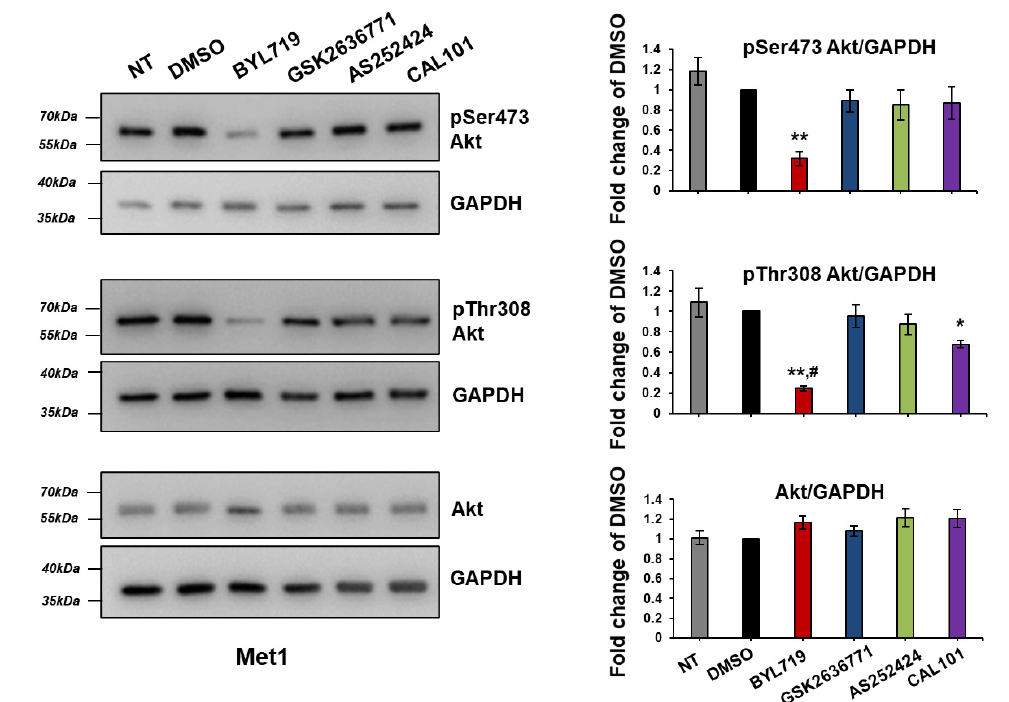
Figure 10. BYL719 inhibits Akt phosphorylation in Met1 cells. Met1 cells were treated with 1 µ M of the isoform-specific inhibitors in complete medium supplemented with 10% FBS. Control cells were treated with DMSO or left untreated (NT). Cells were lysed after 1 h and Akt phosphorylation at residues Ser473 and Thr308 as well as total levels of Akt were determined by Western blotting. Glyceraldehyde 3-phosphate dehydrogenase (GAPDH) was used as loading control. Signals were visualized using Chemidoc™ MP Imaging System. Graphs indicate results from densitometry analysis of phosphorylated or total Akt normalized to loading control and expressed as fold change of results from DMSO-treated cells. Data are means ± SEM from n = 3 independent experiments (apart from NT in pSer437 Akt graph, n = 2). * p < 0.05, ** p < 0.01 vs. DMSO; # p < 0.05 vs. NT.